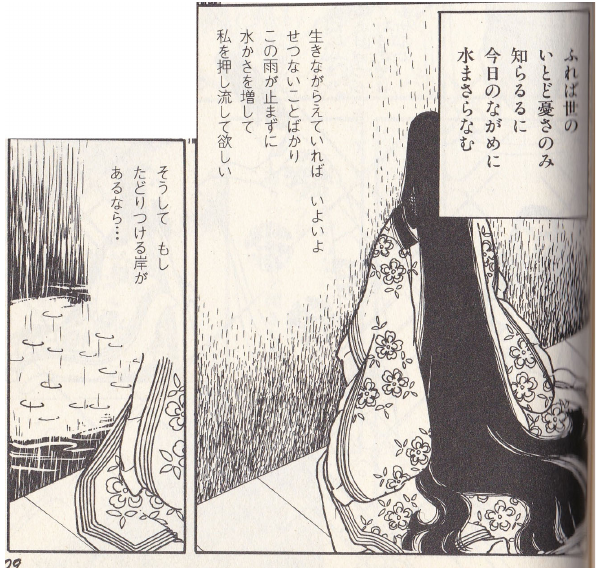
Figure 11. The woman gazes out on a rainy day (Kosakabe and Tanaka, Manga Izumi Shikibu nikki , 1990), 109. Courtesy of